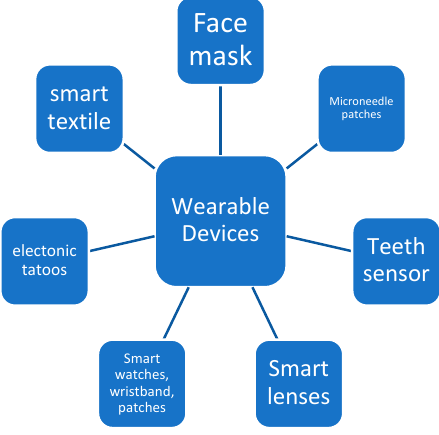
Figure 7. Wearable devices.